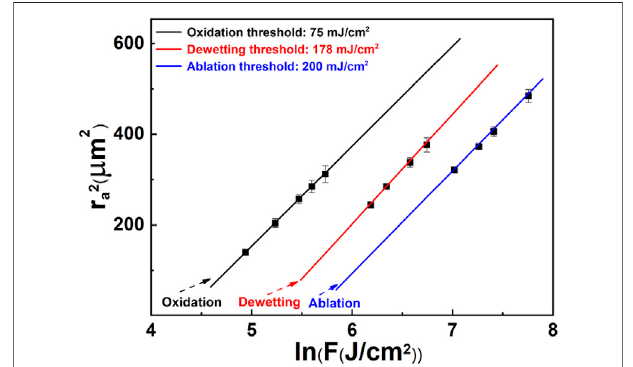
FIGURE 2 | Normalized laser intensities of the oxidation, dewetting and ablation threshold on the Cu thin fi lm.